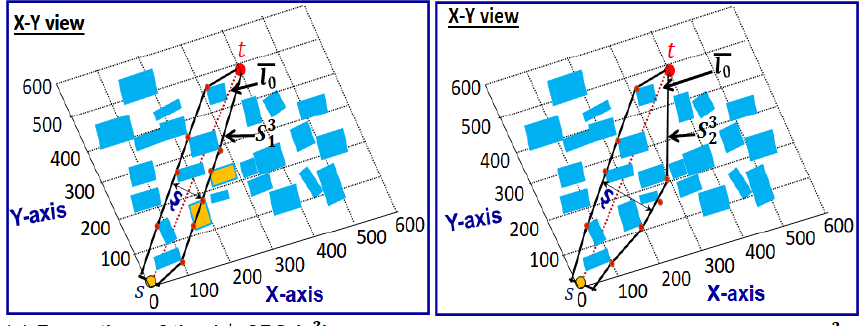
Figure 6. Overview of constrained polygonal space ( S 3